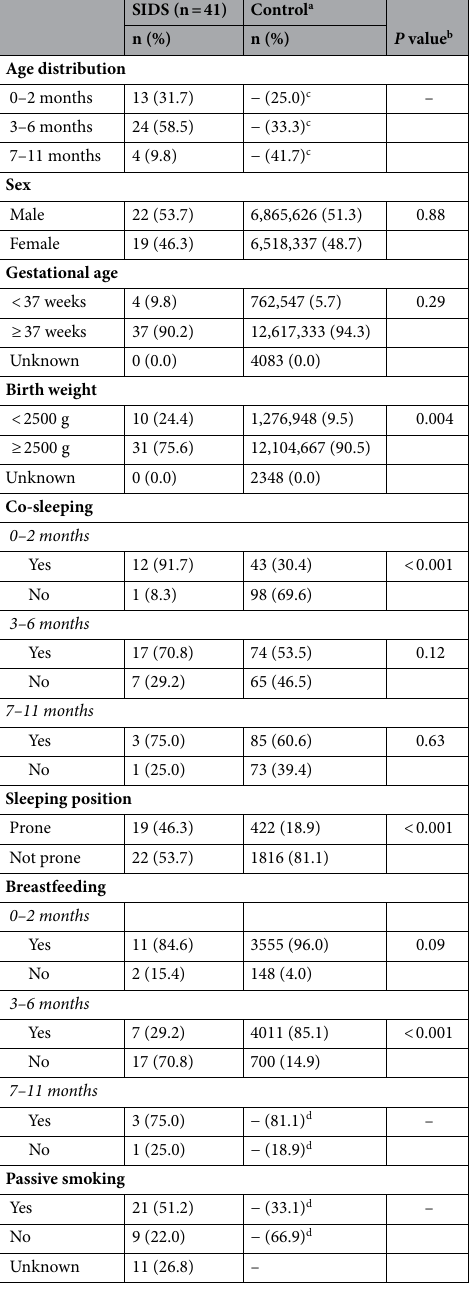
Table 5. Comparisons of demographic characteristics between SIDS and general infants. a Control of age, sex, gestational age, and birth weight were from the Japanese national vital statics database between 2006 to 2018 18 ; co-sleeping was from Ichikawa et al. 29 ; sleeping position was from Togari et al. 30 ; breastfeeding was from the Japanese national nutrition survey on preschool children in 2015 31 ; passive smoking was from the